Question: Condense the content of this figure into a single sentence.
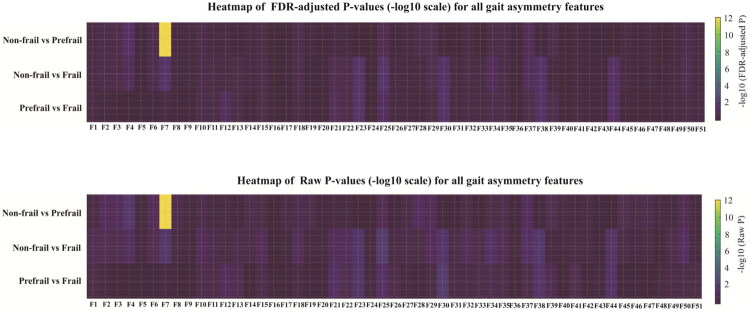
Answer: Heatmap of FDR-adjusted p-values (expressed as − log10) and Raw p-values (expressed as − log10) for all 51 gait asymmetry features. Note: Columns represent the 51 asymmetry parameters (full feature names are provided in Table S1 ), and rows represent the three pairwise group comparisons (Non-frail vs Prefrail, Non-frail vs Frail, and Prefrail vs Frail). Brighter colors indicate smaller p-values and stronger group differences.